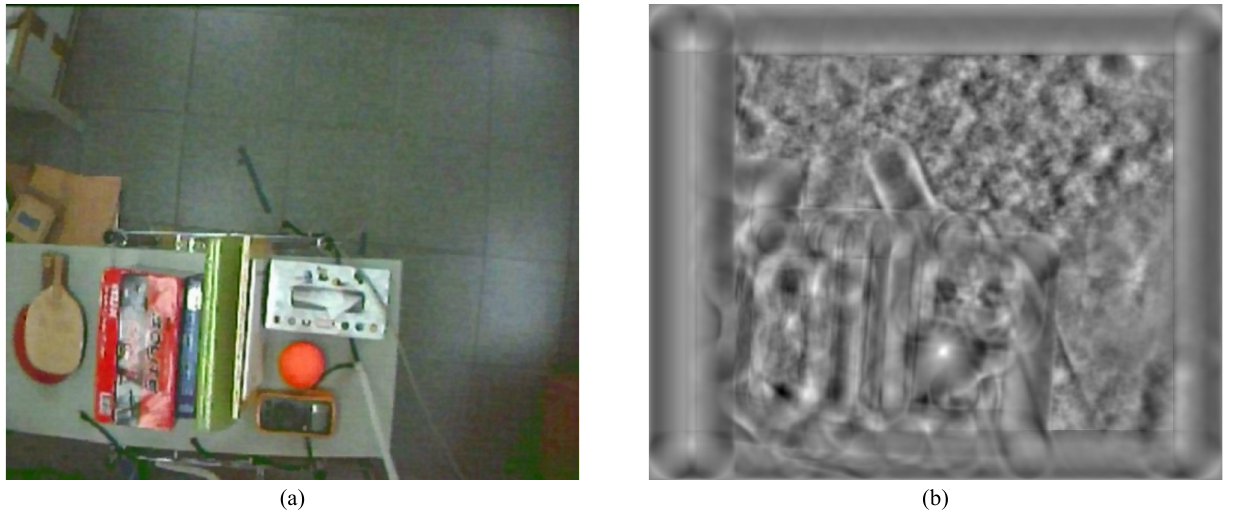
Figure 2. ( a ) Image with a complicated background captured by the camera and ( b ) the normalized cross-correlation